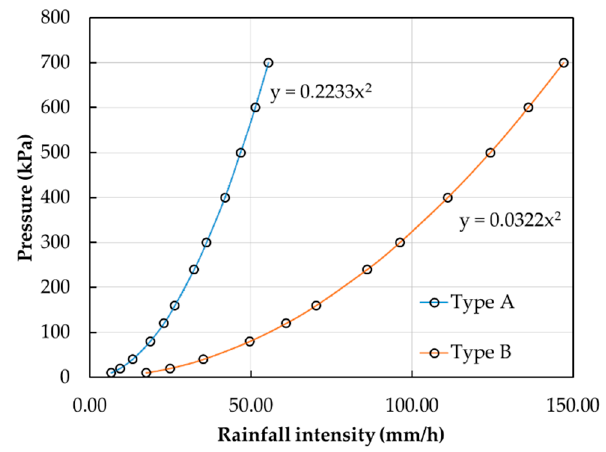
Figure 7. Rainfall intensity vs. pressure.